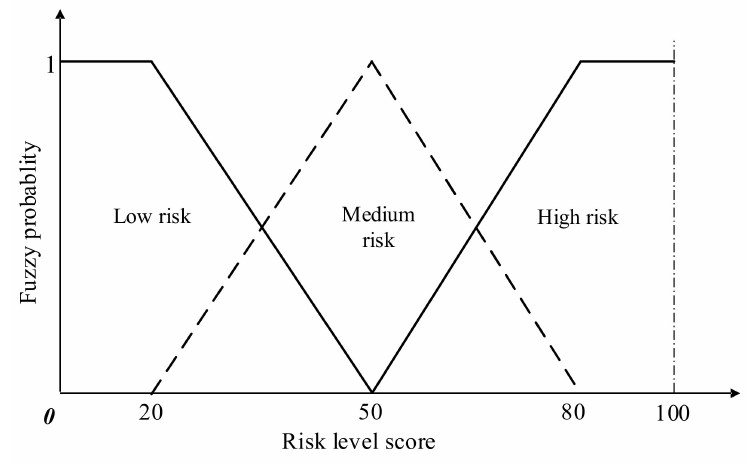
Figure 5. A scoring framework example of the risk level.